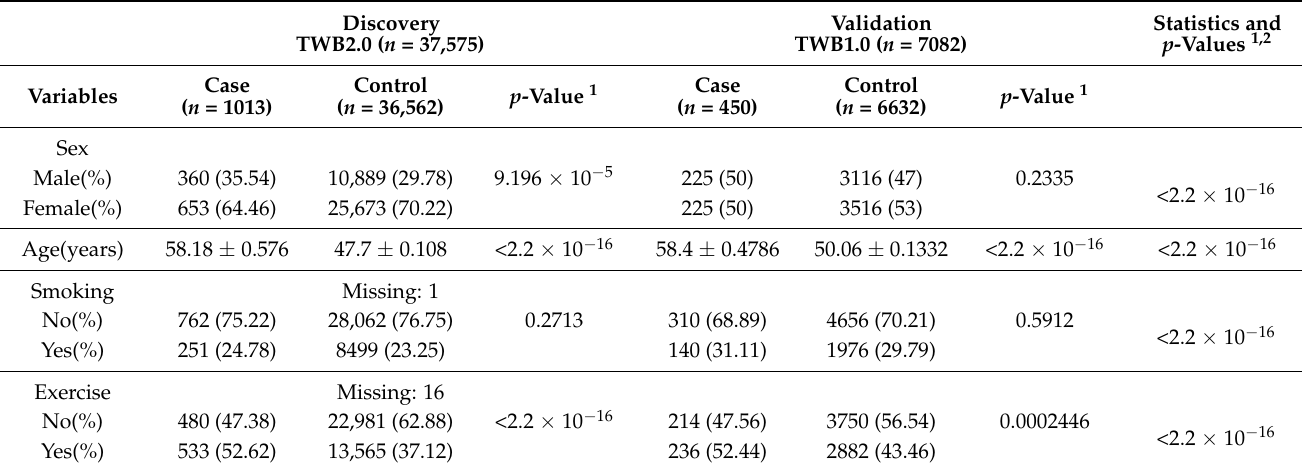
Statistics and p -Values